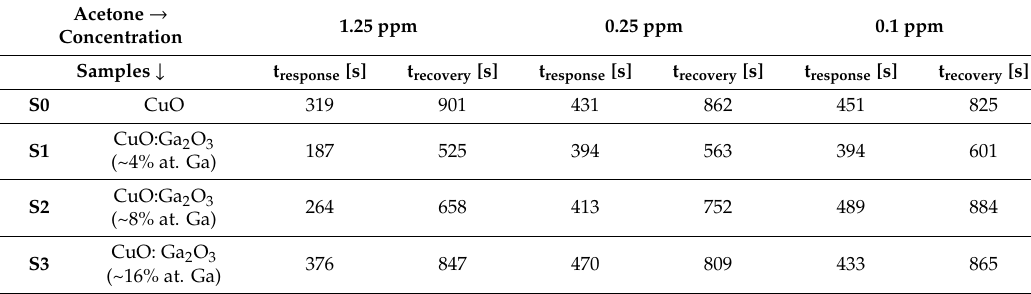
Table 4. Response and recovery times obtained for CuO and CuO:Ga films with di ff erent